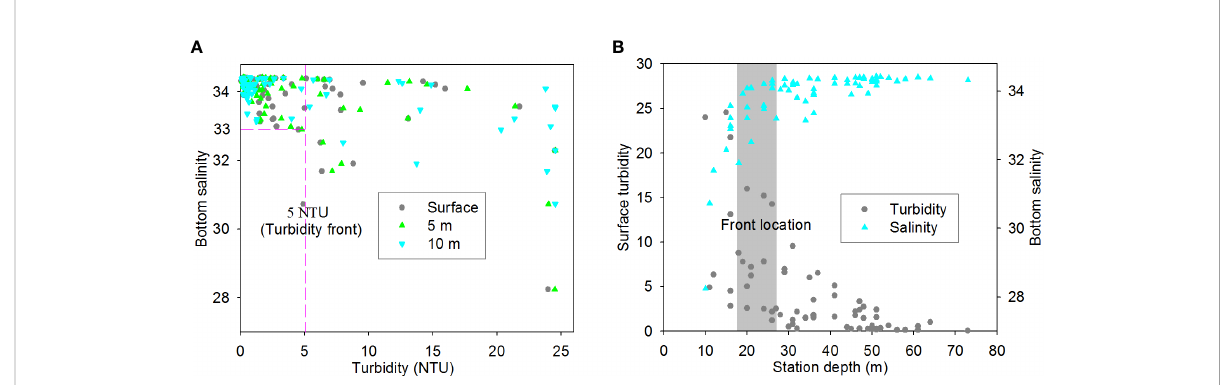
FIGURE 11 Relationships between (A) bottom salinity and upper-layer turbidity and between (B) surface turbidity (bottom salinity) and station depth off the CE in August 2013. The grey area in panel b generally indicates the front location, where surface turbidity and bottom salinity signi fi cant changed with water